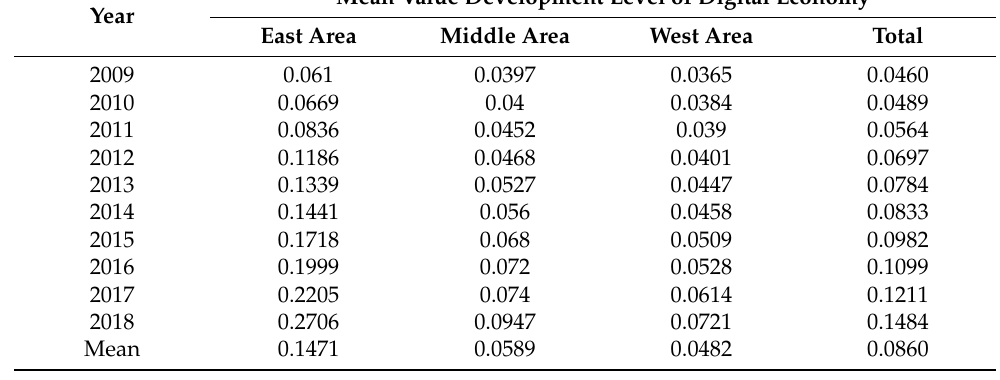
Table 4. Average development level of digital economy in eastern, central and western regions from 2009 to 2018.